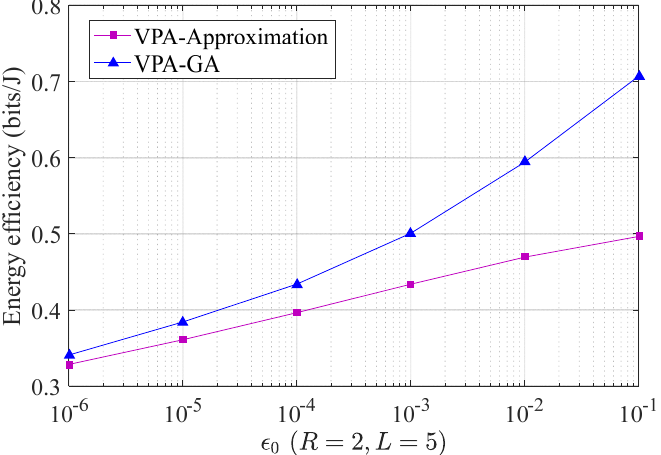
Figure 11. The comparison between the VPA-GA method and VPA-Asymptotic method under K = 0 .